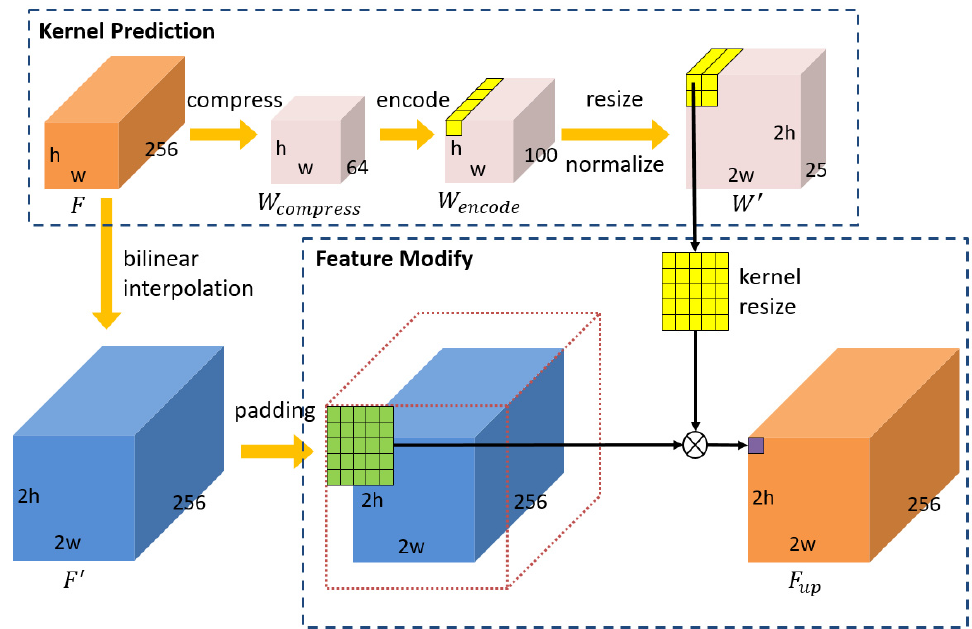
Figure 2. The structure of CAFUS can be seen above. We choose a prediction kernel size of 5 × 5 and an up-sampling ratio of 2, so the number of channels of the encoded feature map is 100, which is 2 × 2 × 5 × 5 . As for the choice of the number of compressed channels, we found that increasing the number of compressed channels had no significant improvement on the effectiveness of the algorithm.